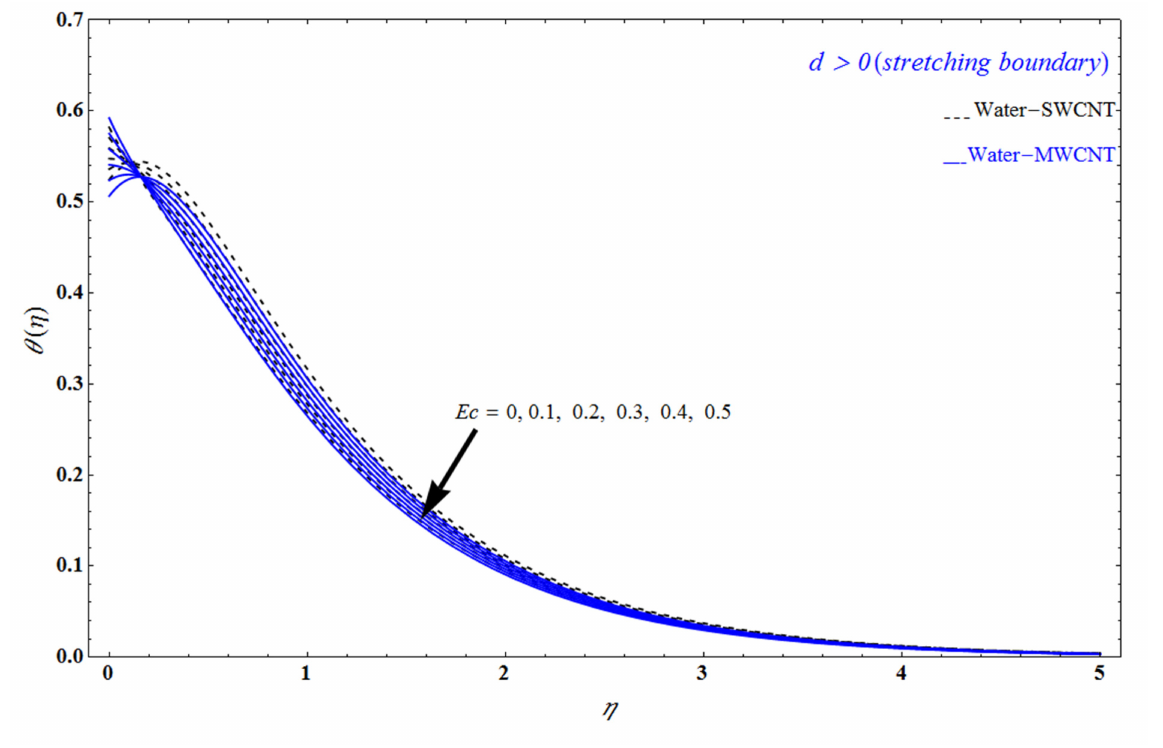
( ) θ η η versus similarity variable for several values of